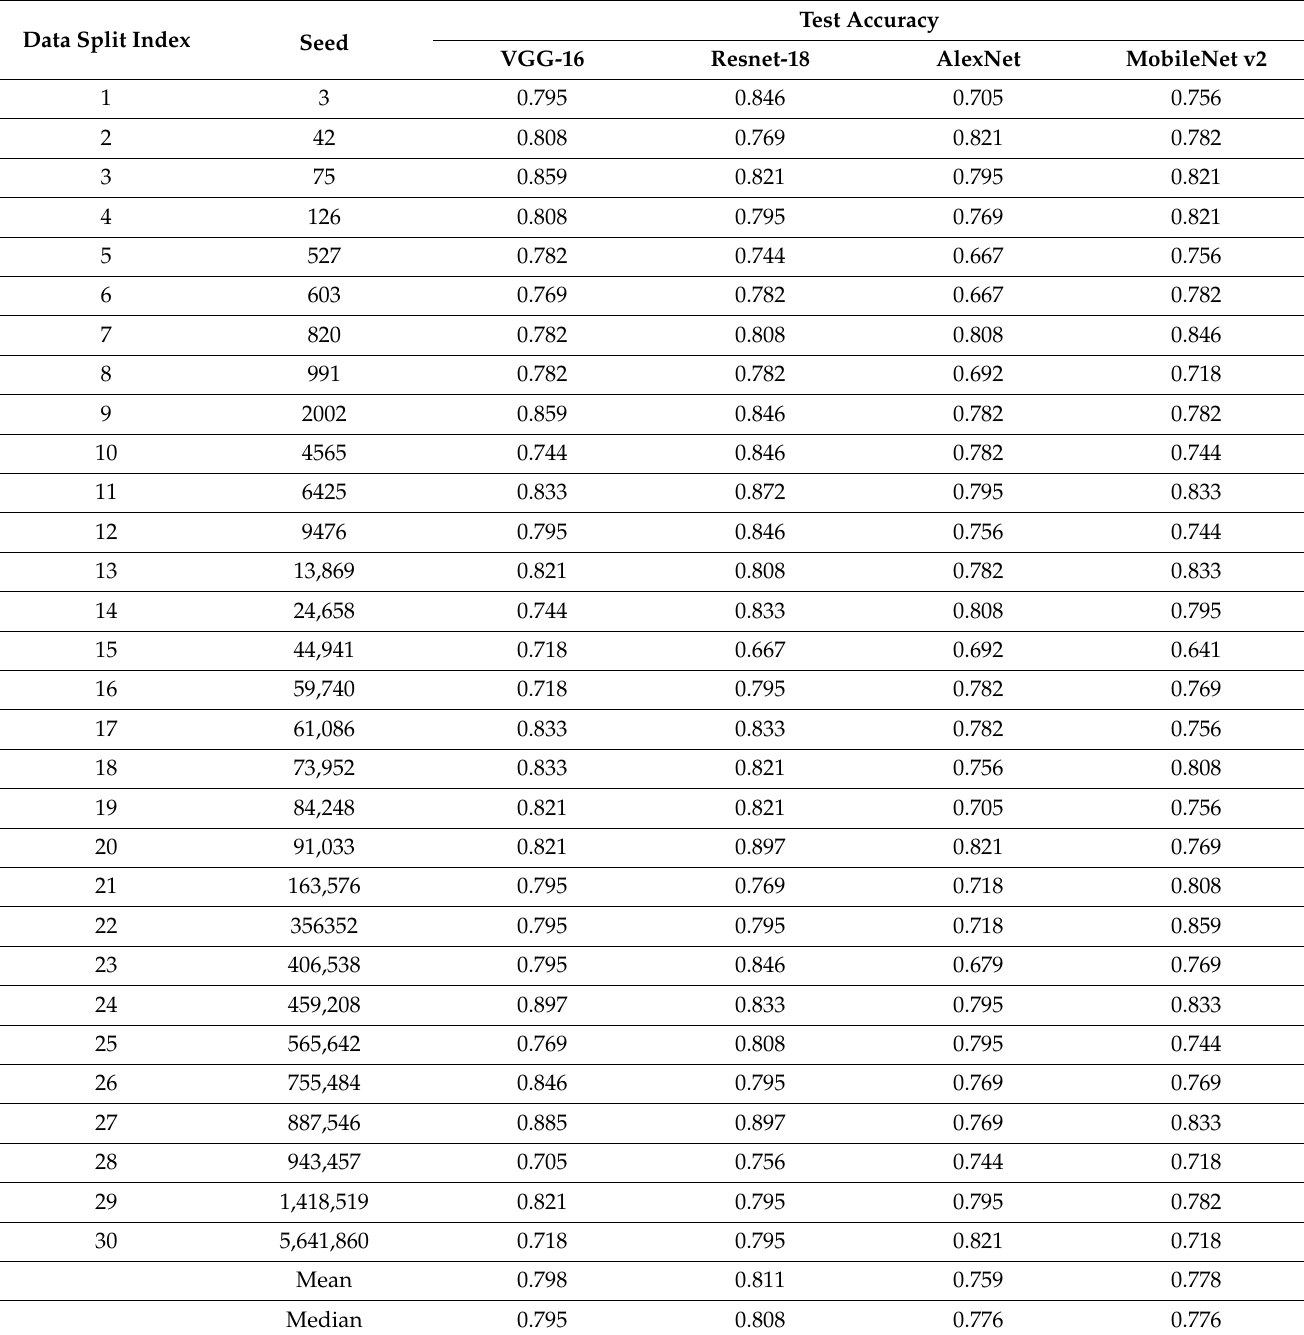
Table 6. Results of Cross Validation Showing Mean and Median Test